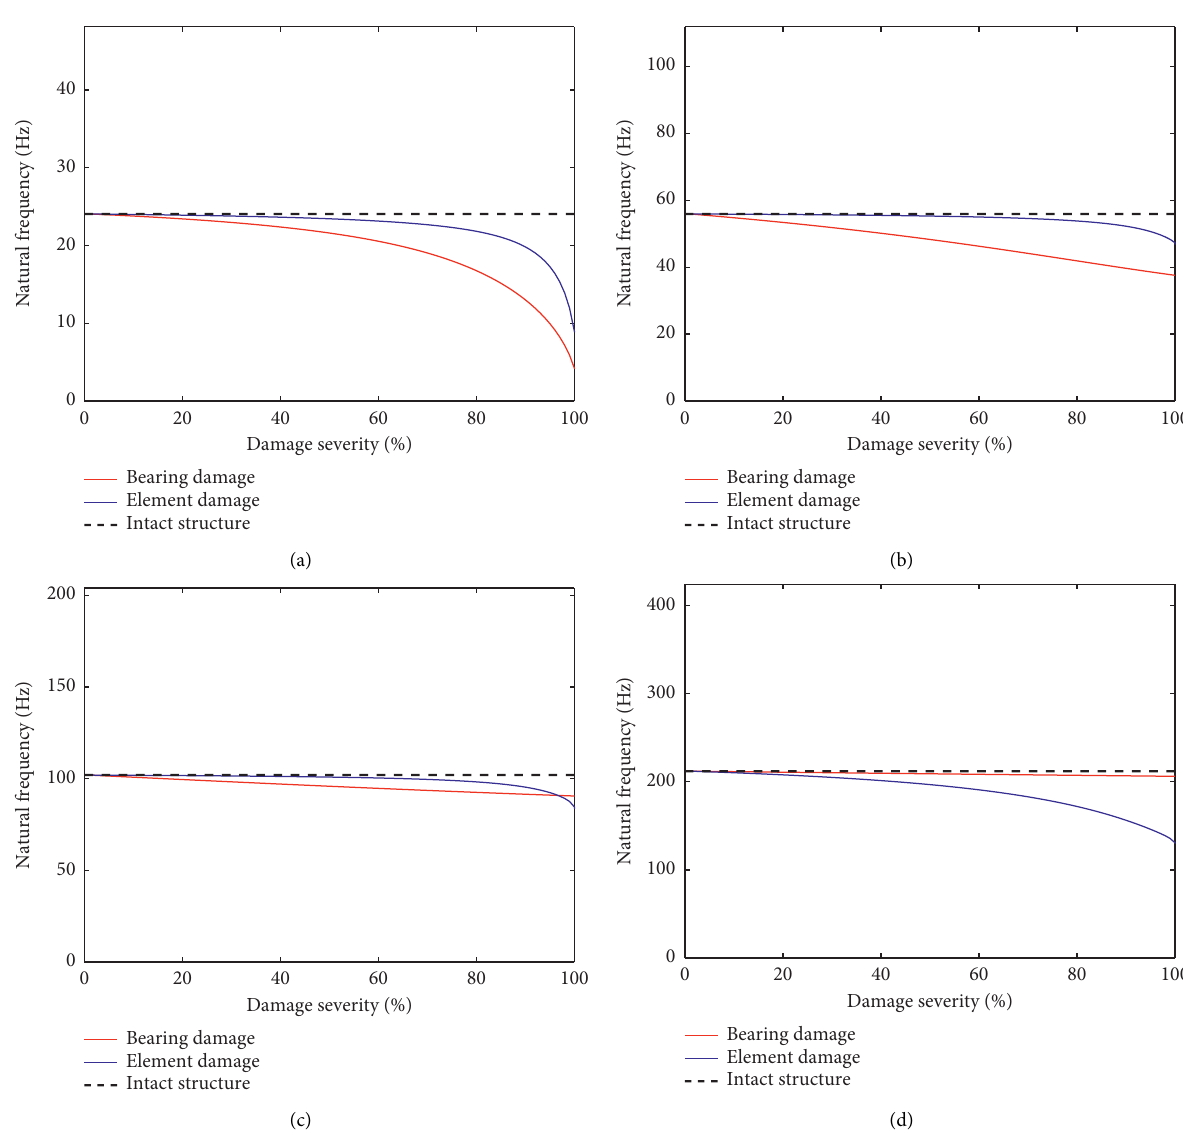
Figure 2: The (a) 1st, (b) 2nd, (c) 3rd, and (d) 4th change curves of frequencies under different damage severities in the structural element and